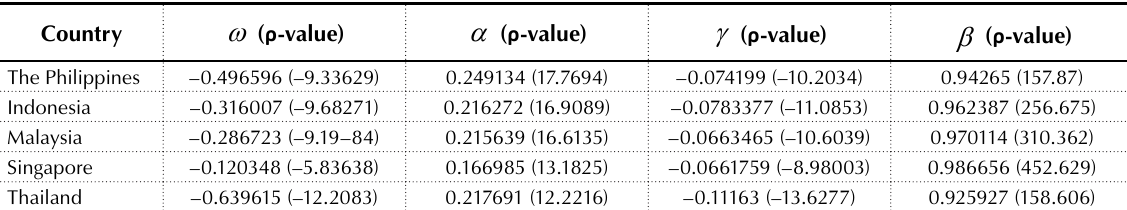
Source: Liu and Hung (2010).